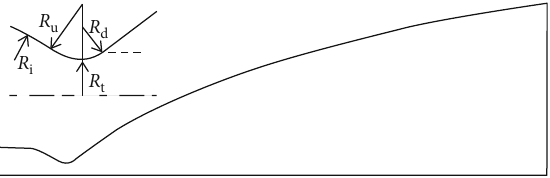
Figure 3: Structure of the nozzle with the area ratio of 210 :1. It is an 80% bell-shape nozzle (compared with standard conical nozzle): R = 12 : 25 mm, R t